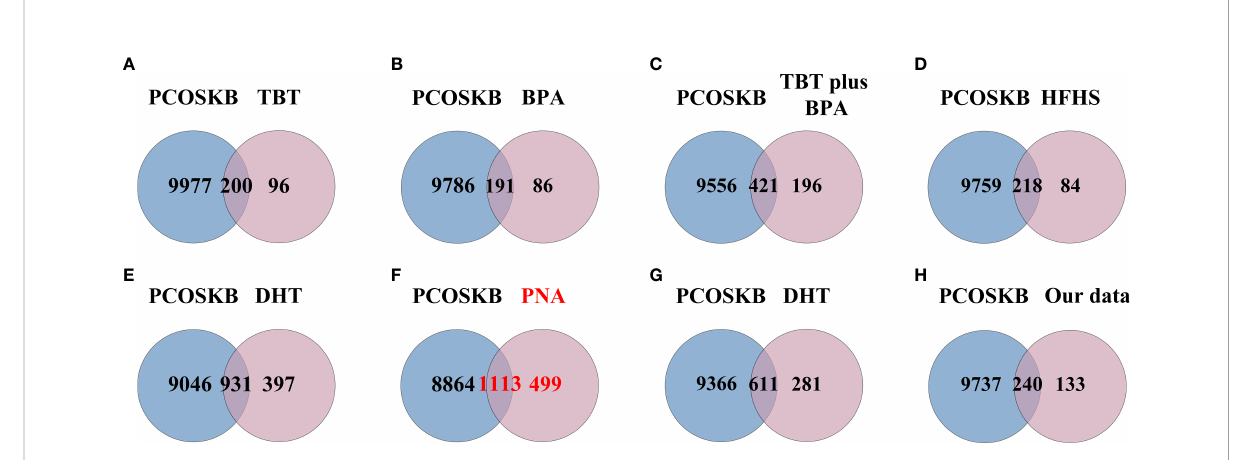
FIGURE 5 Venn diagram showing the intersection of PCOS animal models and genes from PCOSKB. (A) DEGs of the TBT-induced PCOS rat model. (B) DEGs of the BPA-induced PCOS rat model. (C) DEGs of the TBT plus BPA-induced PCOS rat model. (D) DEGs of the HFHS-induced PCOS rat model. (E) DEGs of the DHT-induced PCOS rat model. (F) DEGs of the PNA PCOS mouse model. (G) DEGs of the DHT-induced PCOS mouse model. (H) DEGs of the DHEA plus HFD-induced PCOS mouse